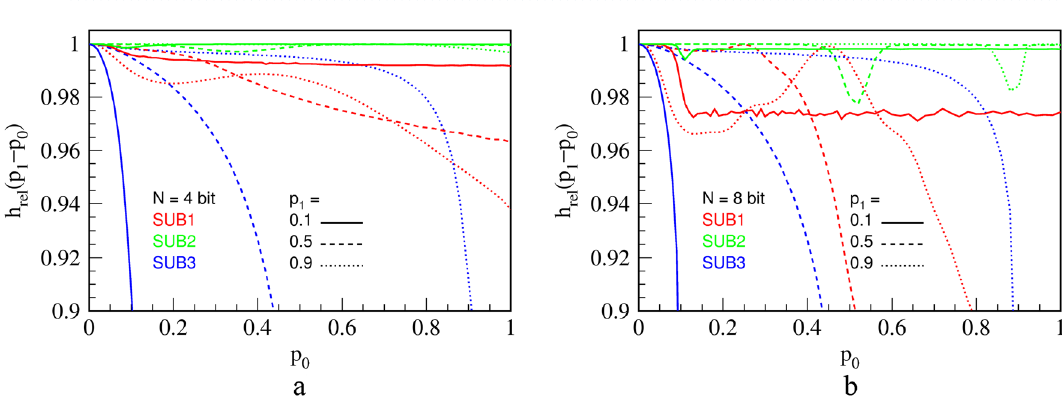
Figure 22. Relative KS entropy of the output of the three subtraction circuits that calculate p 1 − p 0 , for p 1 = 0.1, 0.5 and 0.9, for a counter of N = 4 bits (a) and N = 8 bits (b)